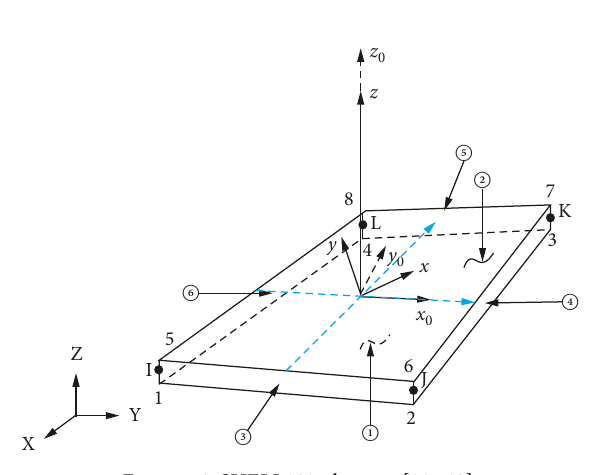
Figure 6: SHELL181 element [39, 48].